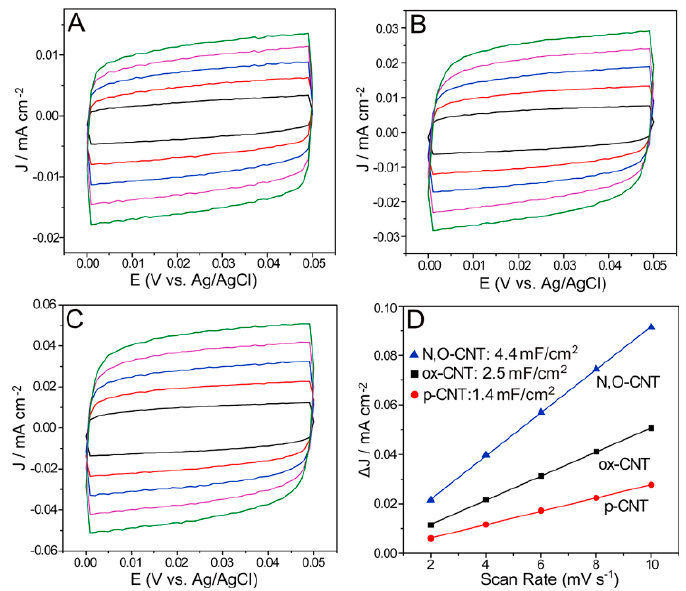
Figure 7. CV curves at different scan rates (2, 4, 6, 8, and 10 mV s − 1 ) of ( A ) p-CNT, ( B ) ox-CNT, and ( C ) N, O-CNT. ( D ) The corresponding difference in the current density at 0.025 V plotted against scan rate; the calculated C dl values are shown as the inset.